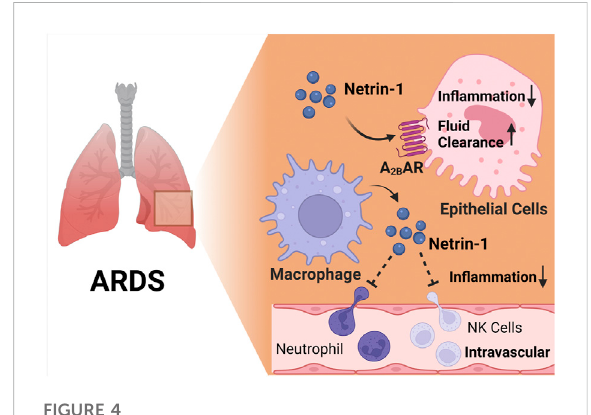
The netrin-1/Adora2b link in acute respiratory distress syndrome (ARDS). Several studies implicate that netrin-1 provide lung protection during ARDS. In alveolar epithelial cells, netrin-1 enhances alveolar fl uid clearance and reduces